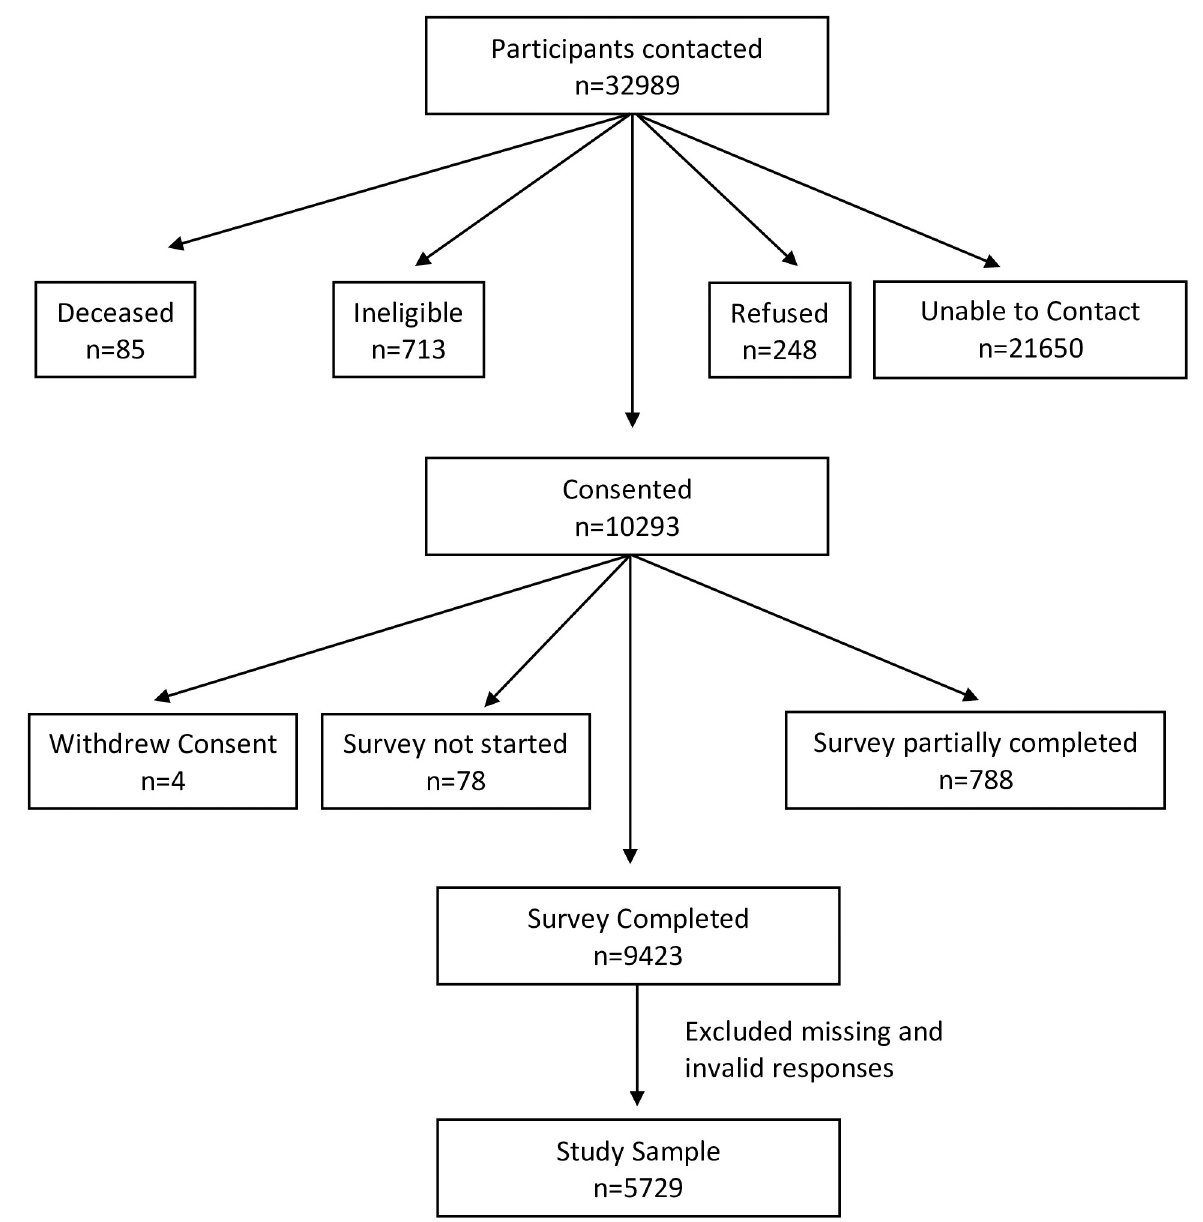
Fig 1. COVID-19 survey recruitment